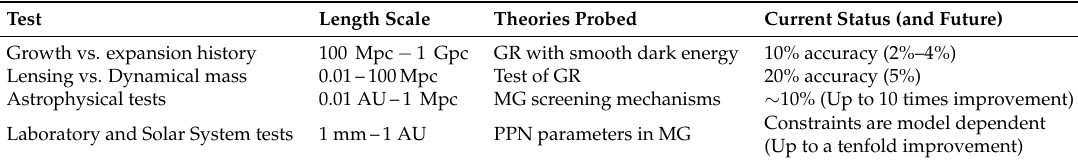
Table 5. Bridging the length scales to test the cosmological model. Experimental tests of gravity and dark sector couplings, at their typical length scales. Massive gravity (MG) screening mechanisms would show up at short ranges, while smooth dark energy manifests itself at cosmological scales. We give the experimental accuracy from current and future experiments planned over the next decade. The comparison between growth and expansion history comes from combined BAO, supernova, weak lensing, redshift distortion, cosmic microwave background (CMB) lensing, and cluster data. Lensing effects and dynamical mass comparisons can be carried out over a range of scales: inside galaxies, using strong lensing and stellar velocities, and on cosmological scales, using cross-correlations. This is a route to testing screening effects in alternative theories. Laboratory and Solar System tests can also probe dark sector couplings besides short-range effects, but many of the constraints obtained depend on the cosmological